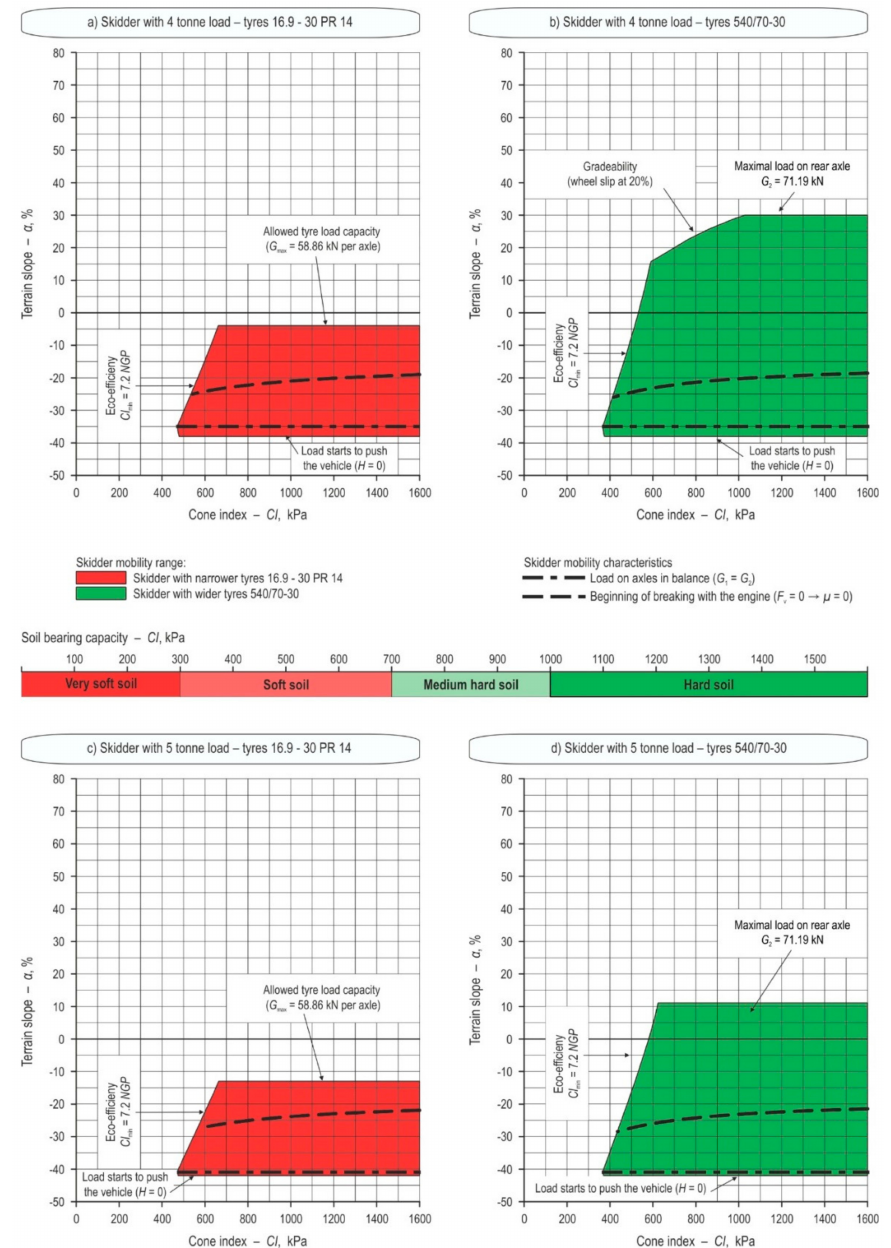
Figure 3. Mobility range of a skidder with 4 and 5 tonne